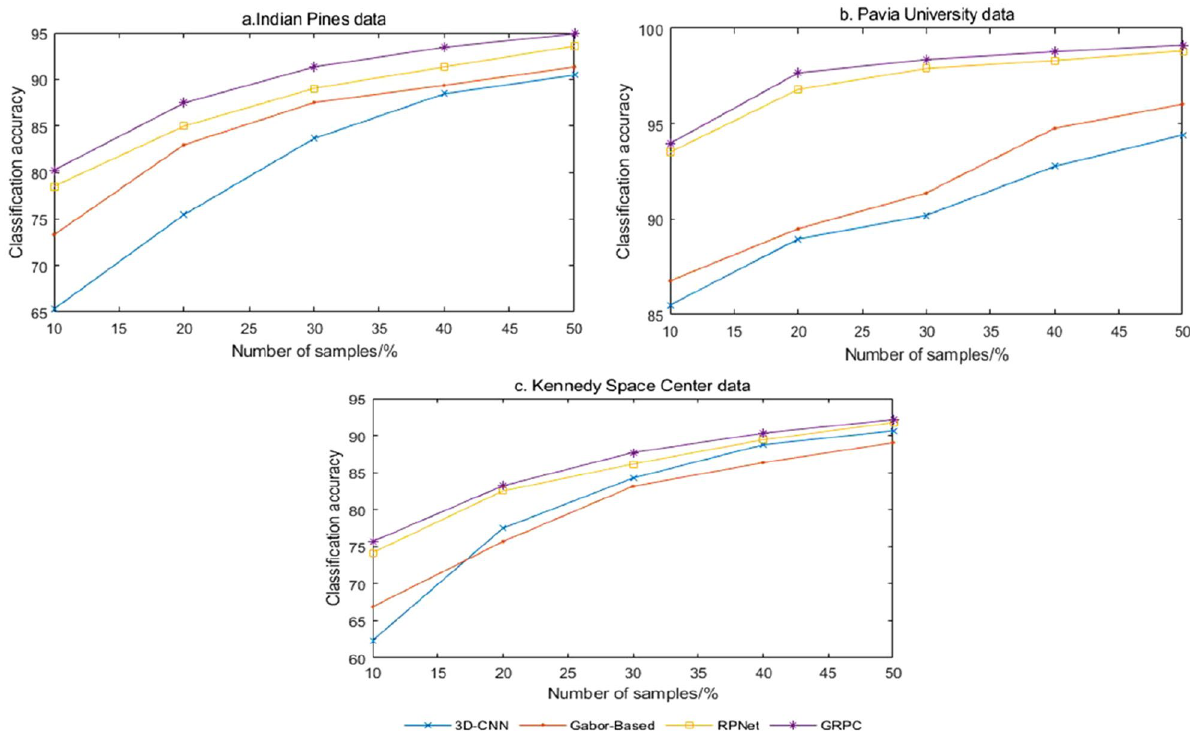
Figure 11. Accuracy with different number of training samples.